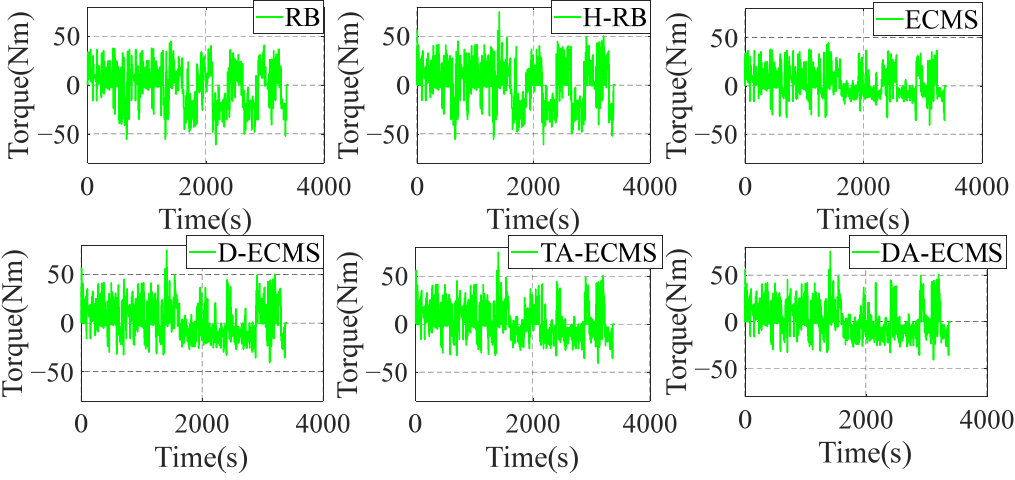
Figure 17. Front motor torque of energy management strategies.